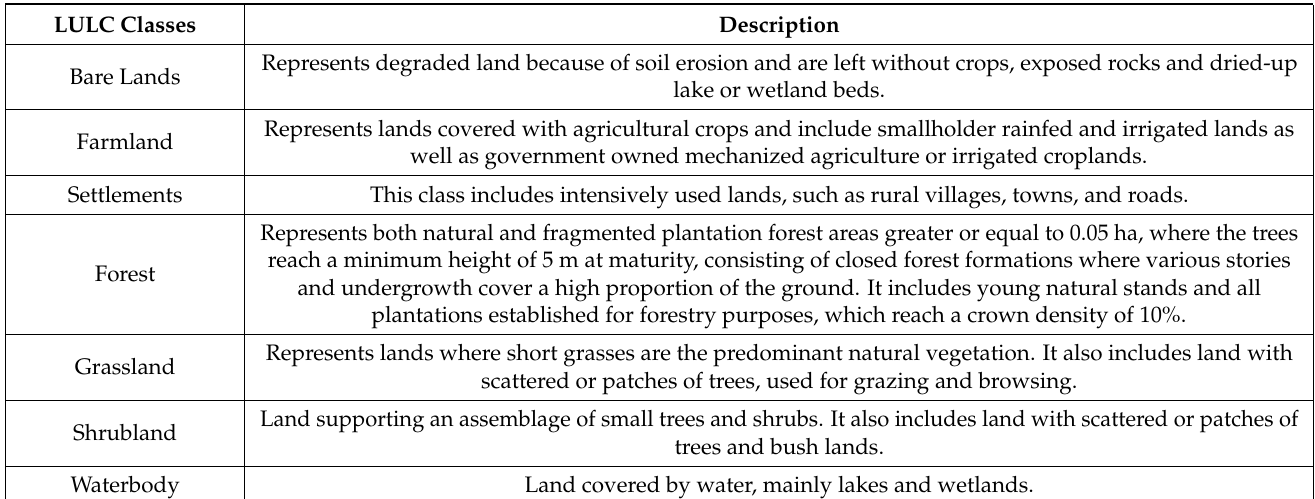
Table 2. Description of land use and land cover (LULC) classes used in the study. LULC Classes